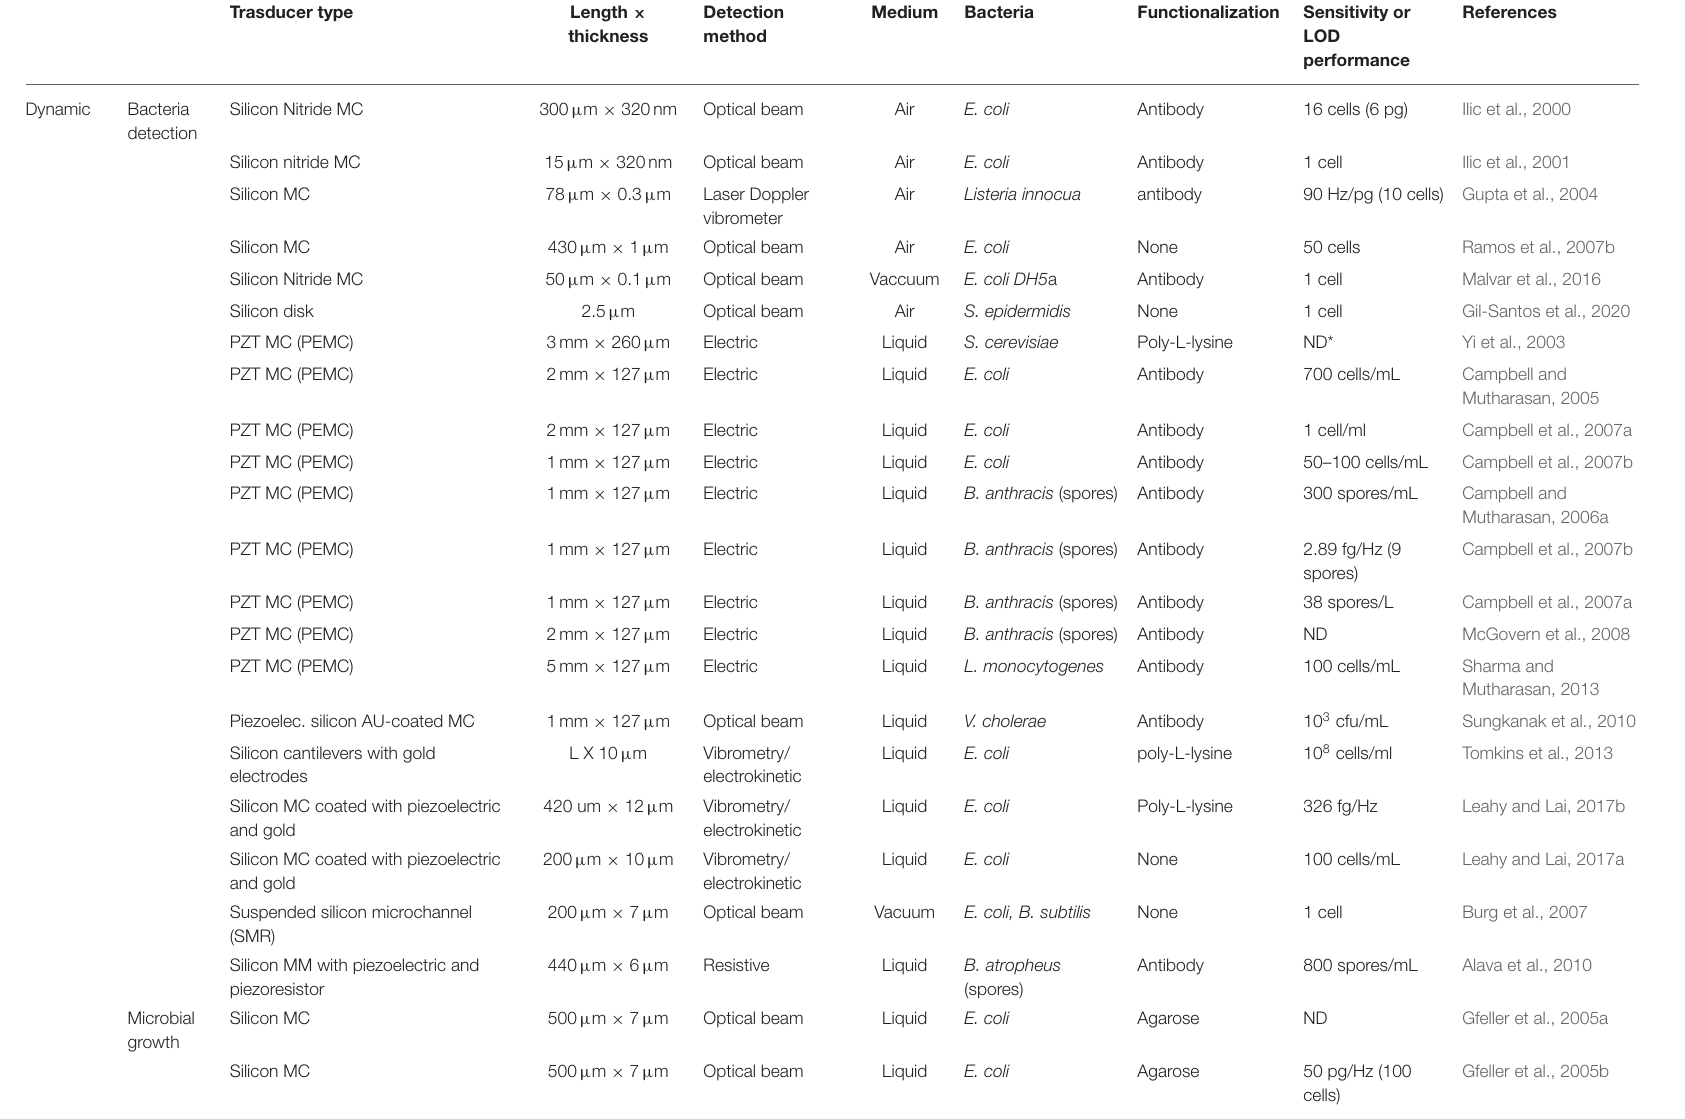
TABLE 1 | Main features of nanomechanical sensors for bacteria